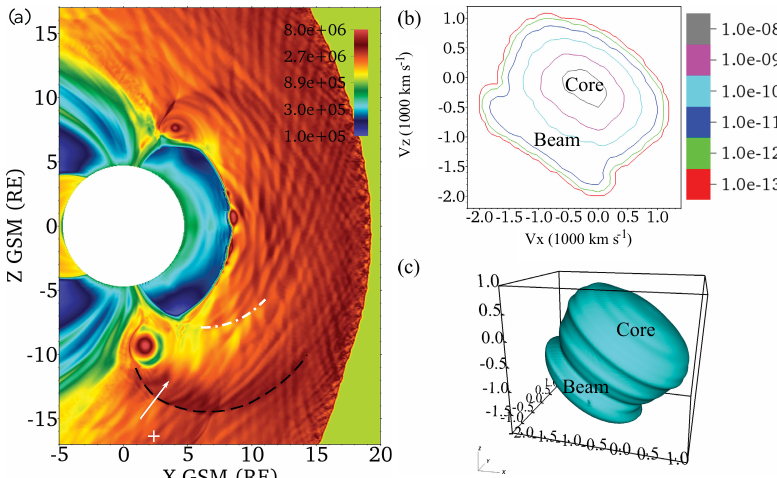
Figure 3. (a) Example of bow (black dashed) and stern (white dash–dotted) fast wave fronts driven by a magnetic island (density peak at ( 2 , − 9 )R E ; colour code: plasma number density; protons m − 3 ; simulation time 1340s). The bow wave accelerates particles ahead of it, as can be seen in the (b) two-dimensional projected isocontour and (c) three-dimensional isocontour plots of the ion velocity distribution (phase space density in s 3 m − 6 ; 3-D isocontour at 1 × 10 − 15 s 3 m − 6 ) taken at the location of the white cross. The core population with very low drift velocity (blue, pink and grey isocontours, centre and top right part of the 3-D isocontour) is preceded by an accelerated population in the − V x and − V z direction. The white arrow shows the location of the profiles shown in Fig. 4.